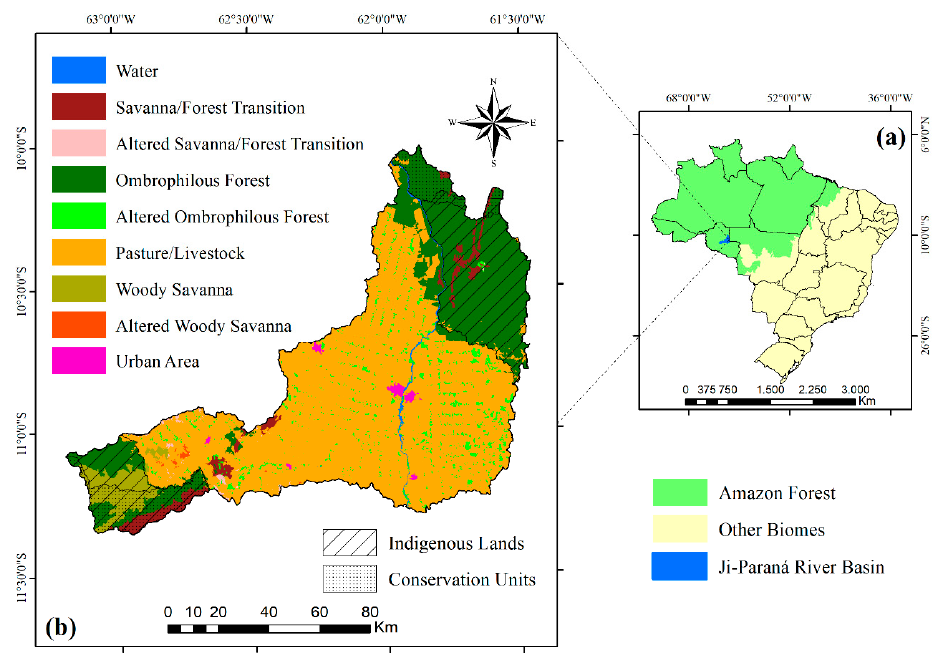
Figure 1. Ji-Paraná River Basin (JPRB): ( a ) location in Brazilian Amazon, and ( b ) land use/cover map.